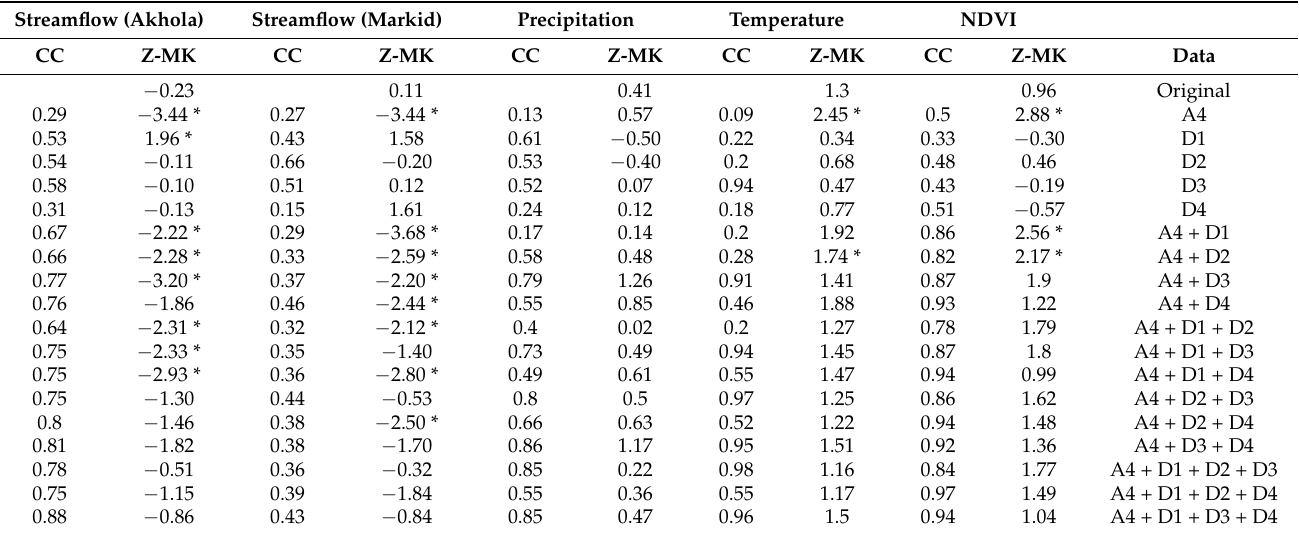
Table 5. Mann–Kendall Z-values and correlation coefficients of monthly time series—Aji-Chay.